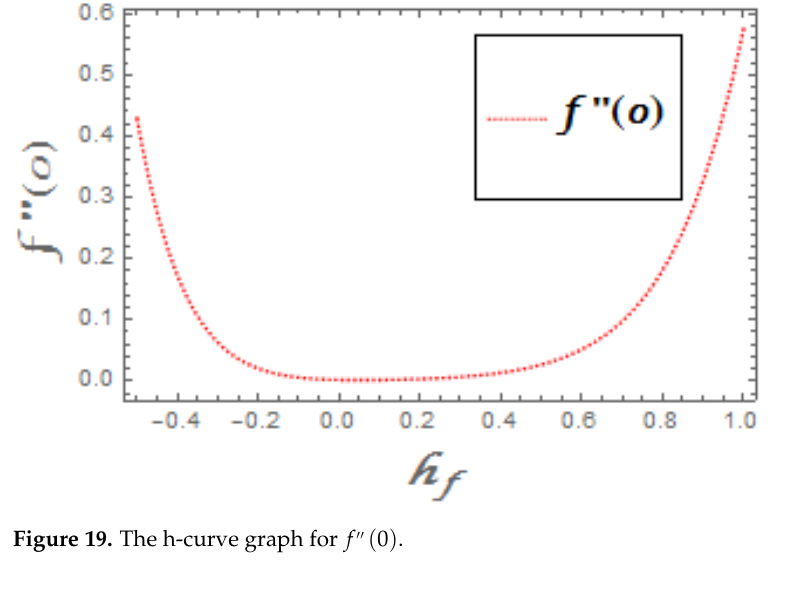
Figure 18. The effect of